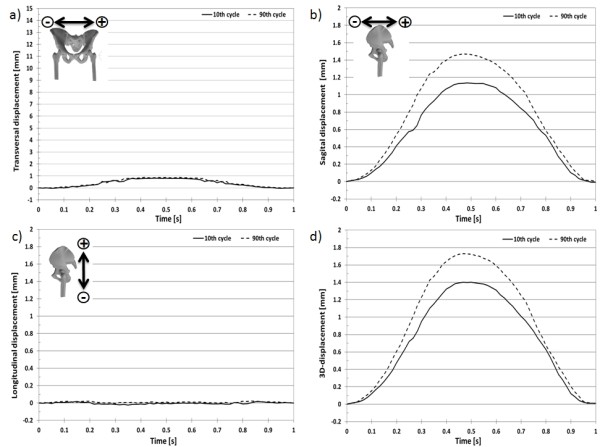
3D-displacement of the femur marker. 3D-displacement of the marker at the femur at the 10th and 90th loading cycle with a sinusoidal load between 100N and 900N.